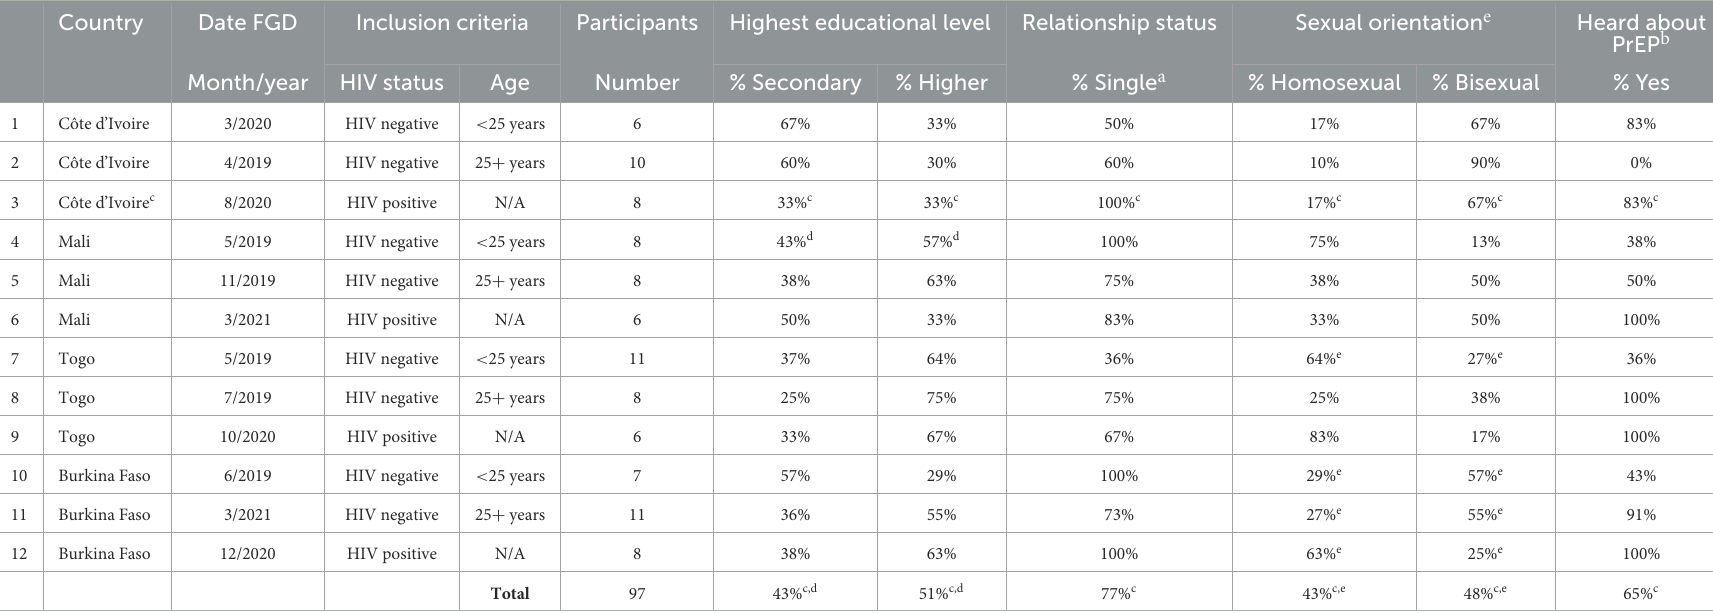
TABLE 1 Focus group discussions with MSM not taking